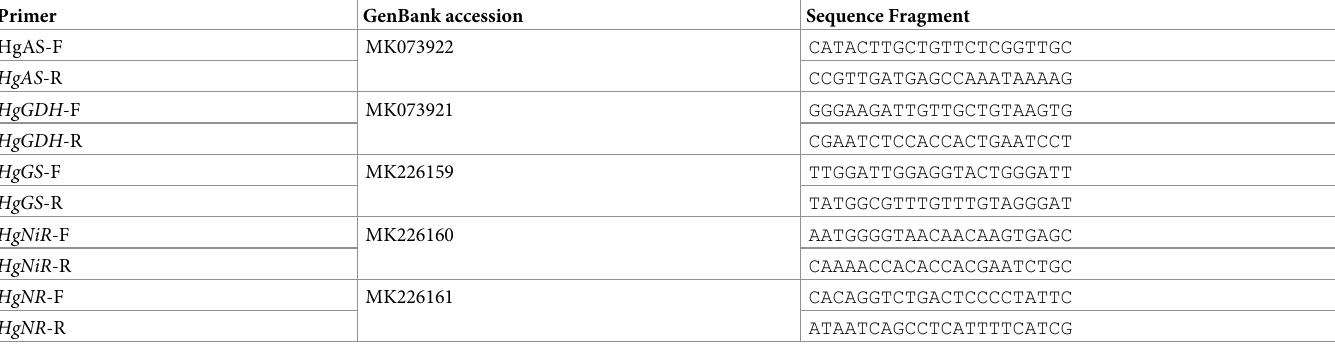
Table 3. Primers used for analysis of the expression of HgNR , HgNiR , HgGS , HgGDH , and HgAS . Primer